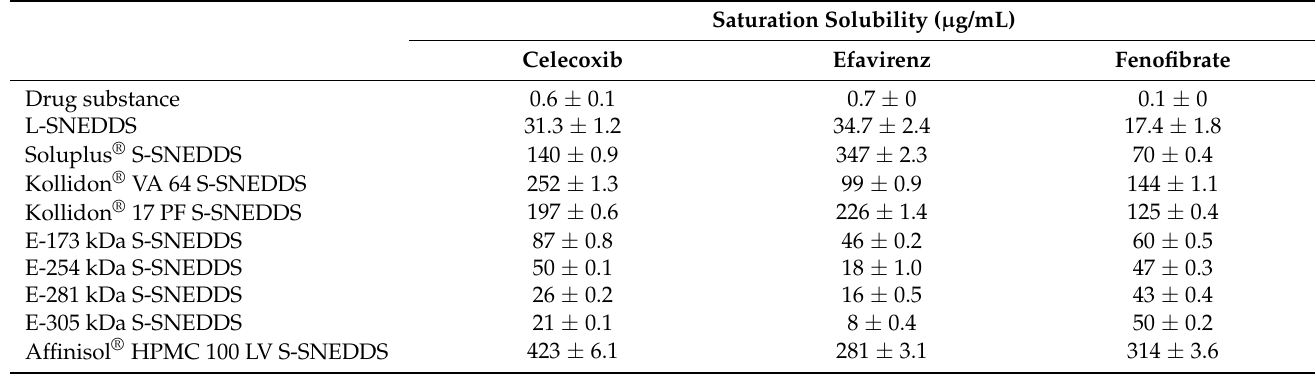
Table 4. Saturation solubility (48 h) of celecoxib, efavirenz, and fenofibrate pure drug substances, L-SNEDDS, and S-SNEDDS in water at 20 ◦ C. Each value designates the mean ± S.D. ( n =